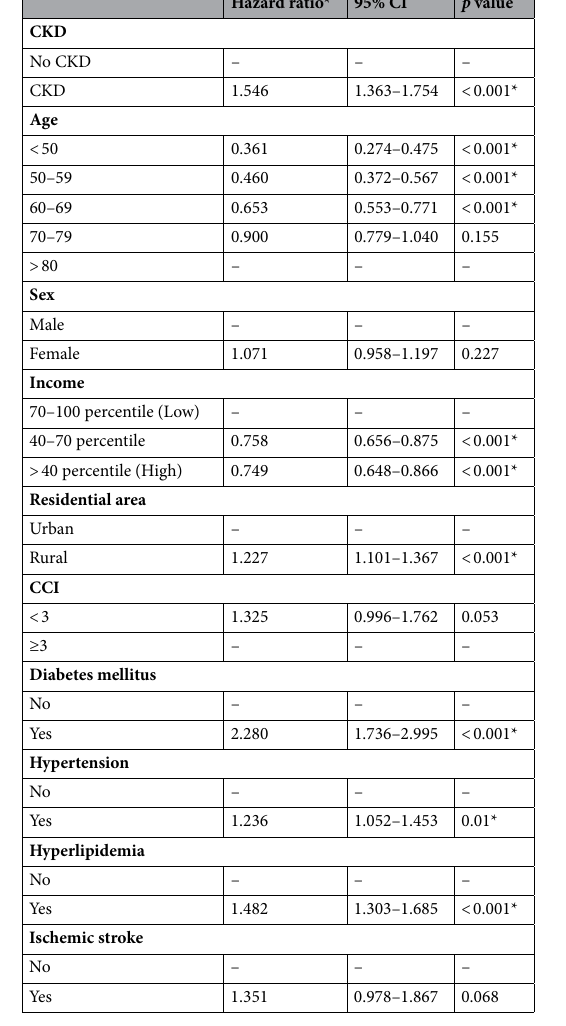
Table 2. Hazard ratios for open-angle glaucoma in multivariable Cox regression analysis. * p < 0.05. CKD , chronic kidney disease; CCI , Charlson comorbidity index. *Adjusted for all variables shown in the